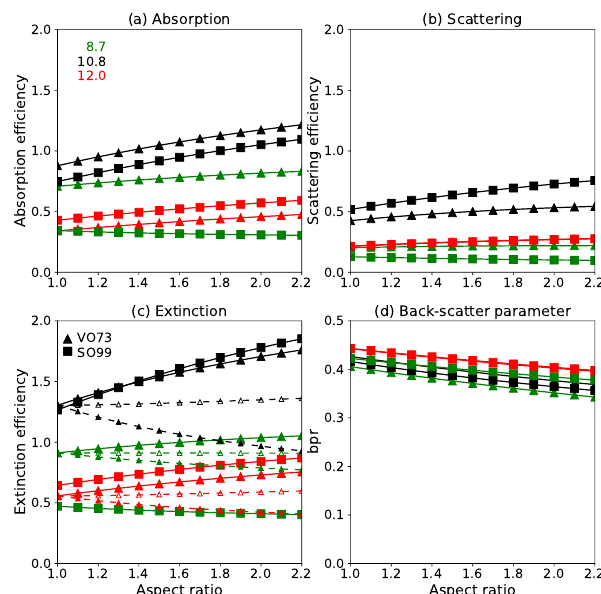
Figure 7. Plots of the derived (a) absorption, (b) scattering, (c) ex- tinction efficiencies, and (d) back-scatter parameters (bpr) for the VO73 and SO99 dust types. These are presented here as a func- tion of particle aspect ratio, for COSMO-MUSCAT dust size bin 3 ( r eff = 1.51µm) for the three MSG-3 SEVIRI channels at 8.7, 10.8, and 12.0µm. The solid lines are for horizontally aligned particles, the dashed lines for randomly oriented particles (open symbols) and for vertically oriented particles (filled symbols). For clarity, the ran- domly and vertically oriented cases are only included in the extinc- tions for VO73